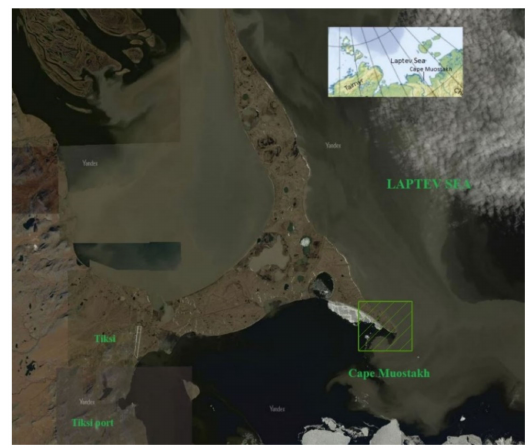
Figure 1. Cape Muostakh, Bykovsky Peninsula (image from Yandex map service [https://yandex. ru/maps/], accessed on 20 December 2020). The study area is in hatching